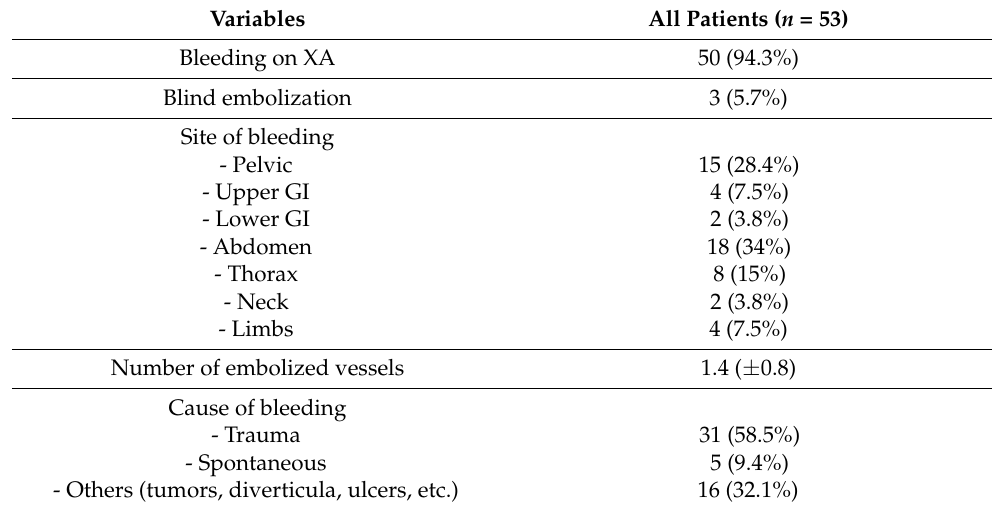
Table 2. Procedure